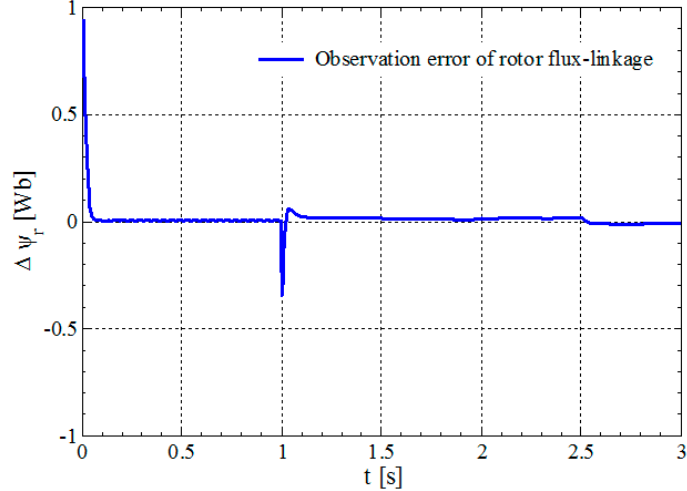
Figure 7. Observation error response of rotor flux-linkage.